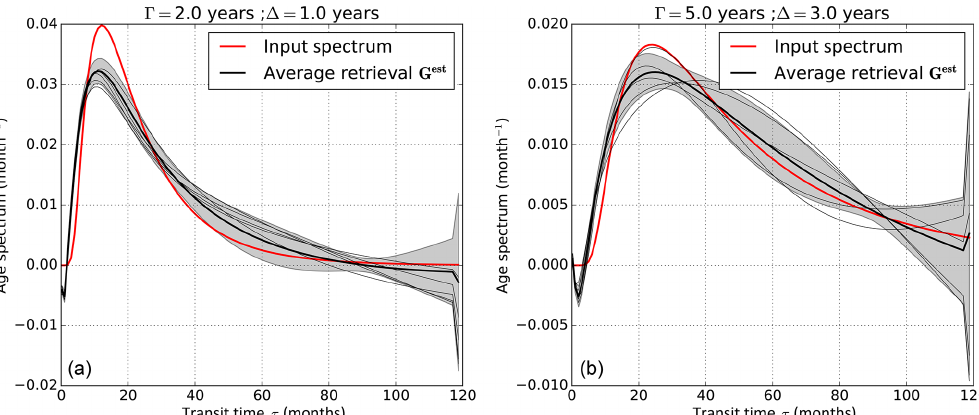
Figure 3. Input age spectra (red) and average retrieved age spectra (black), for an input idealized age spectrum with (cid:48) = 2 years, (cid:49) = 1 year (a) and (cid:48) = 5 years, (cid:49) = 3 years (b) . The average retrieved age spectra are averages of 100 retrievals from 100 sets of pseudo-tracer observations χ obs (i.e., 100 different realizations of the noise in Eq. 25). The gray shading corresponds to ± the standard deviation of the hundred retrievals and shows the dispersion-noise-induced uncertainty. The thin gray curves are individual retrievals.